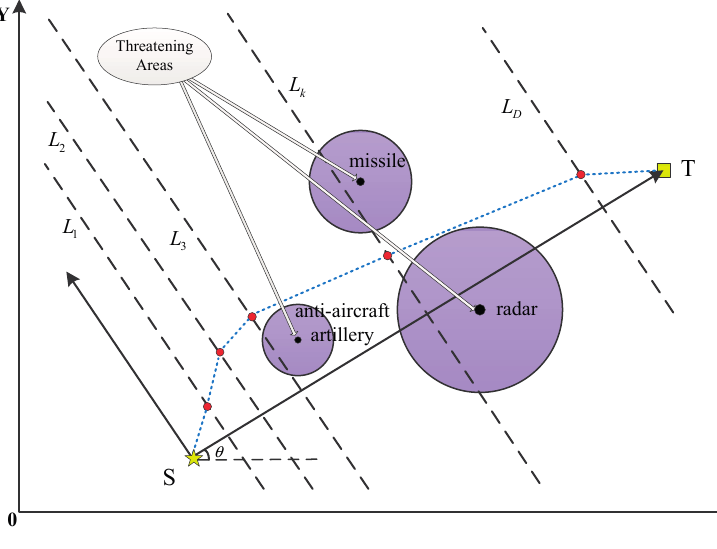
Figure 1. Typical Unmanned combat air vehicle (UCAV) Battle Field